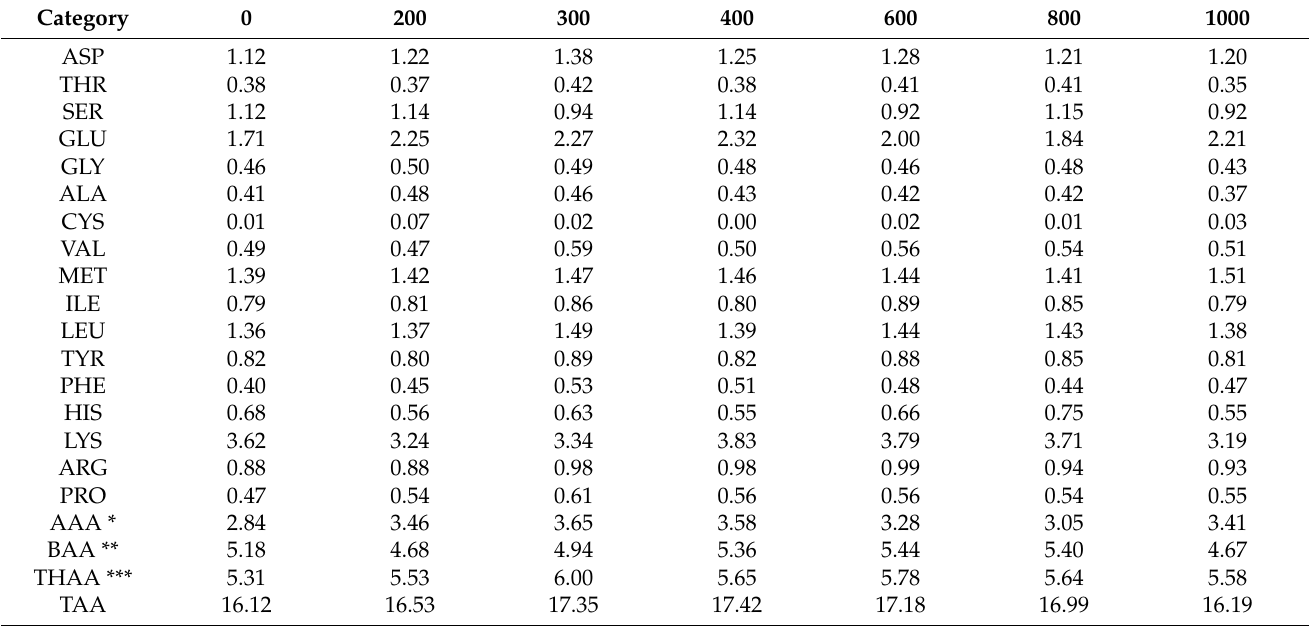
Table 2. Amino acid content of MP hydrolysate pretreated by microwave